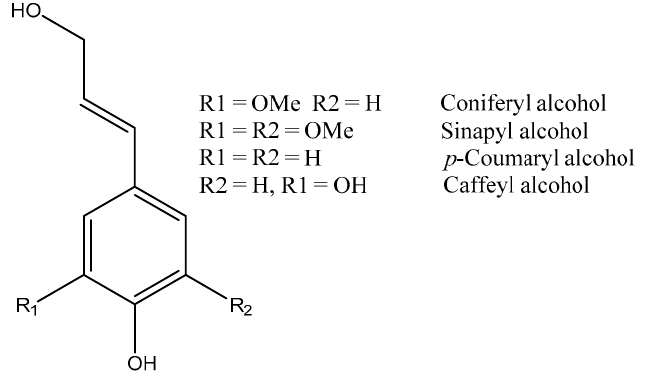
Figure 1. The three building blocks of lignin phenylpropane units structure. Redrawn by the authors [2].